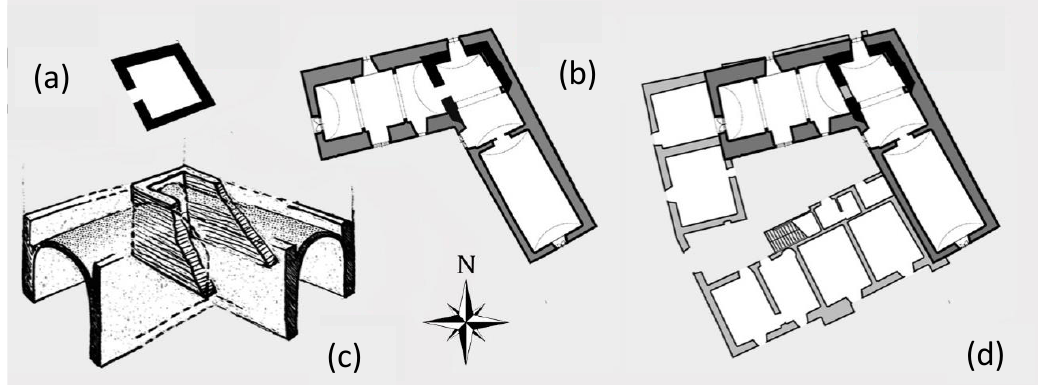
Figure 2. The historical development of the castle: ( a ) the original watchtower, 11th century; ( b ) the enlargement made in the 14th century; ( c ) a sketch of the construction around the tower ruins; ( d ) castle plan in the late 16th century.